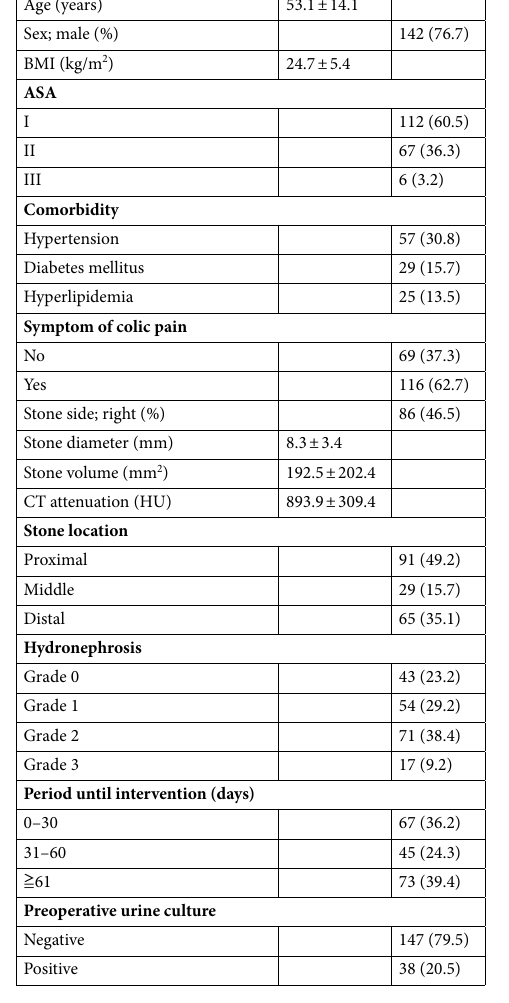
Table 1. Patient and Stone characteristics (n = 185). Data are given in means and standard deviations.